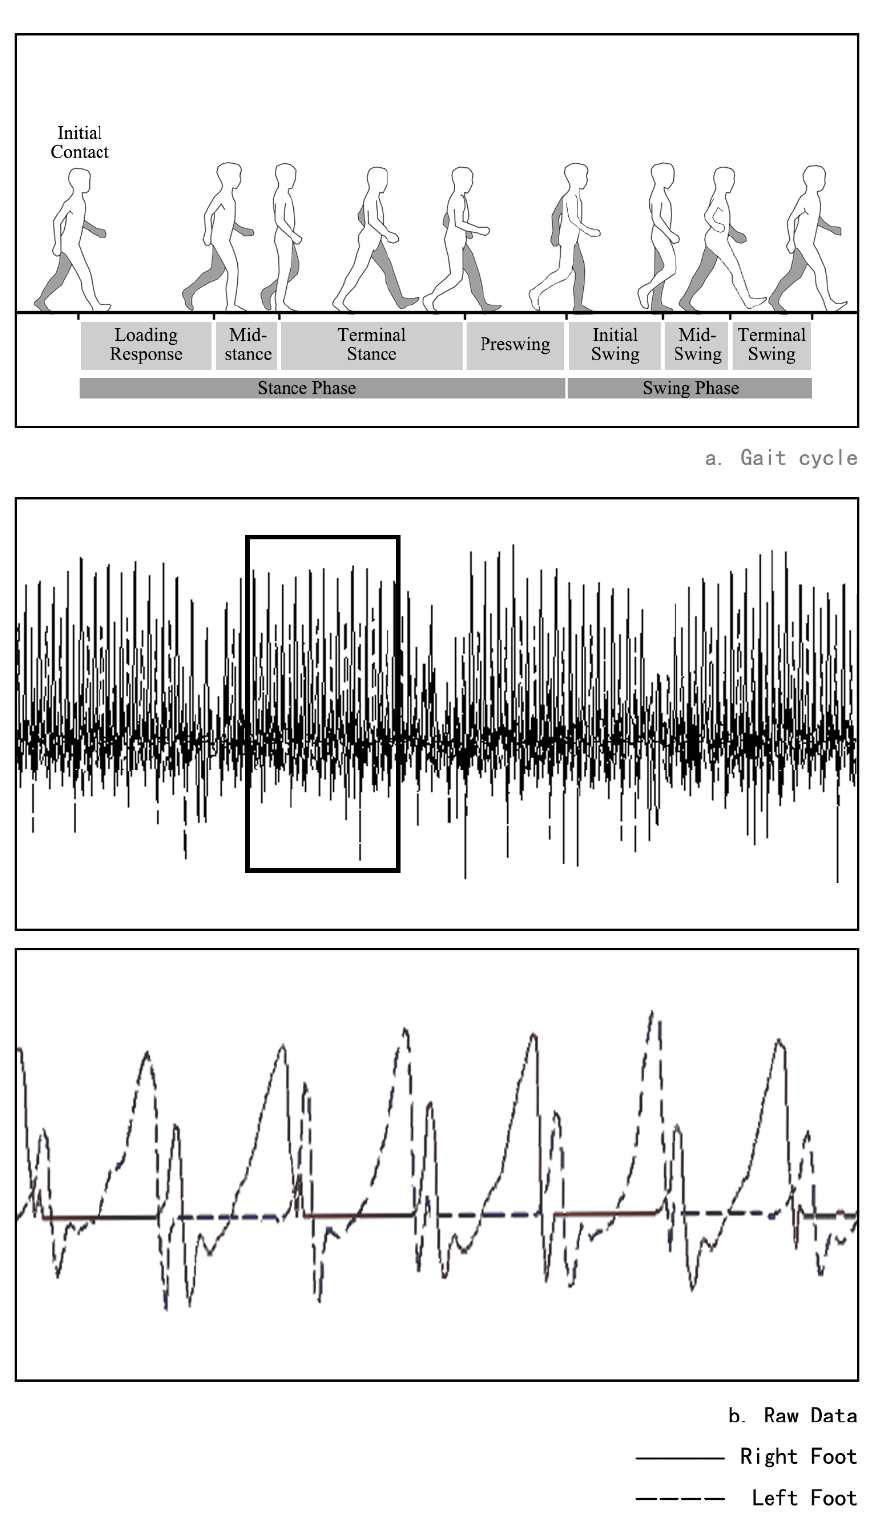
Figure 4. Gait cycle and raw data. ( a ) Schematic diagram of the gait cycle; ( b ) schematic diagram of raw data collected by IDEE.